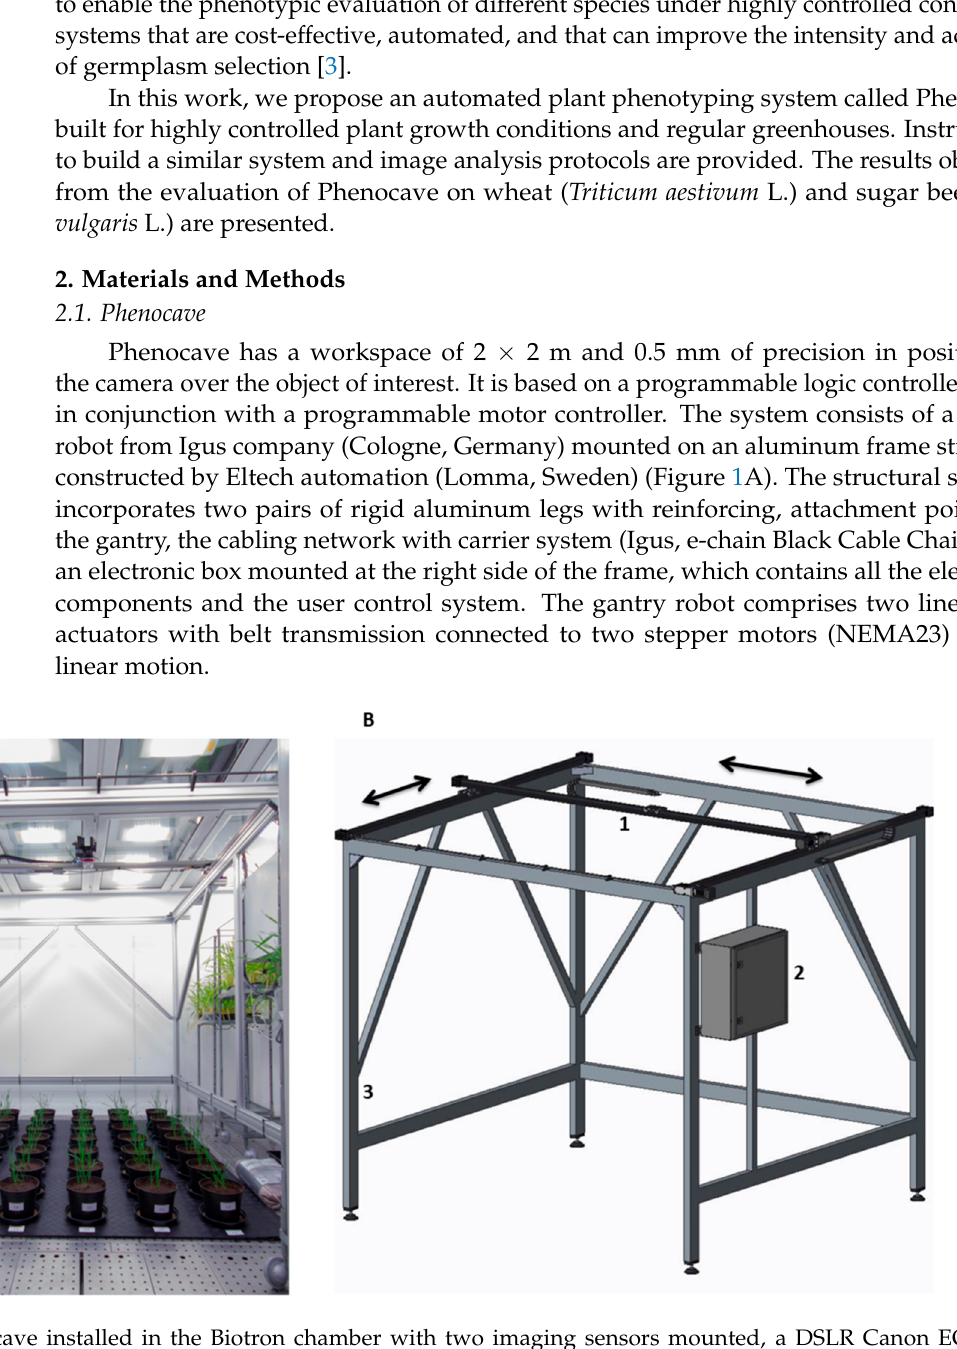
Figure 1. ( A ) Phenocave installed in the Biotron chamber with two imaging sensors mounted, a DSLR Canon EOS and a multispectral MicaSense Altum; ( B ) schematic Phenocave model. The gray arrows indicate the movement on the XY coordinates.